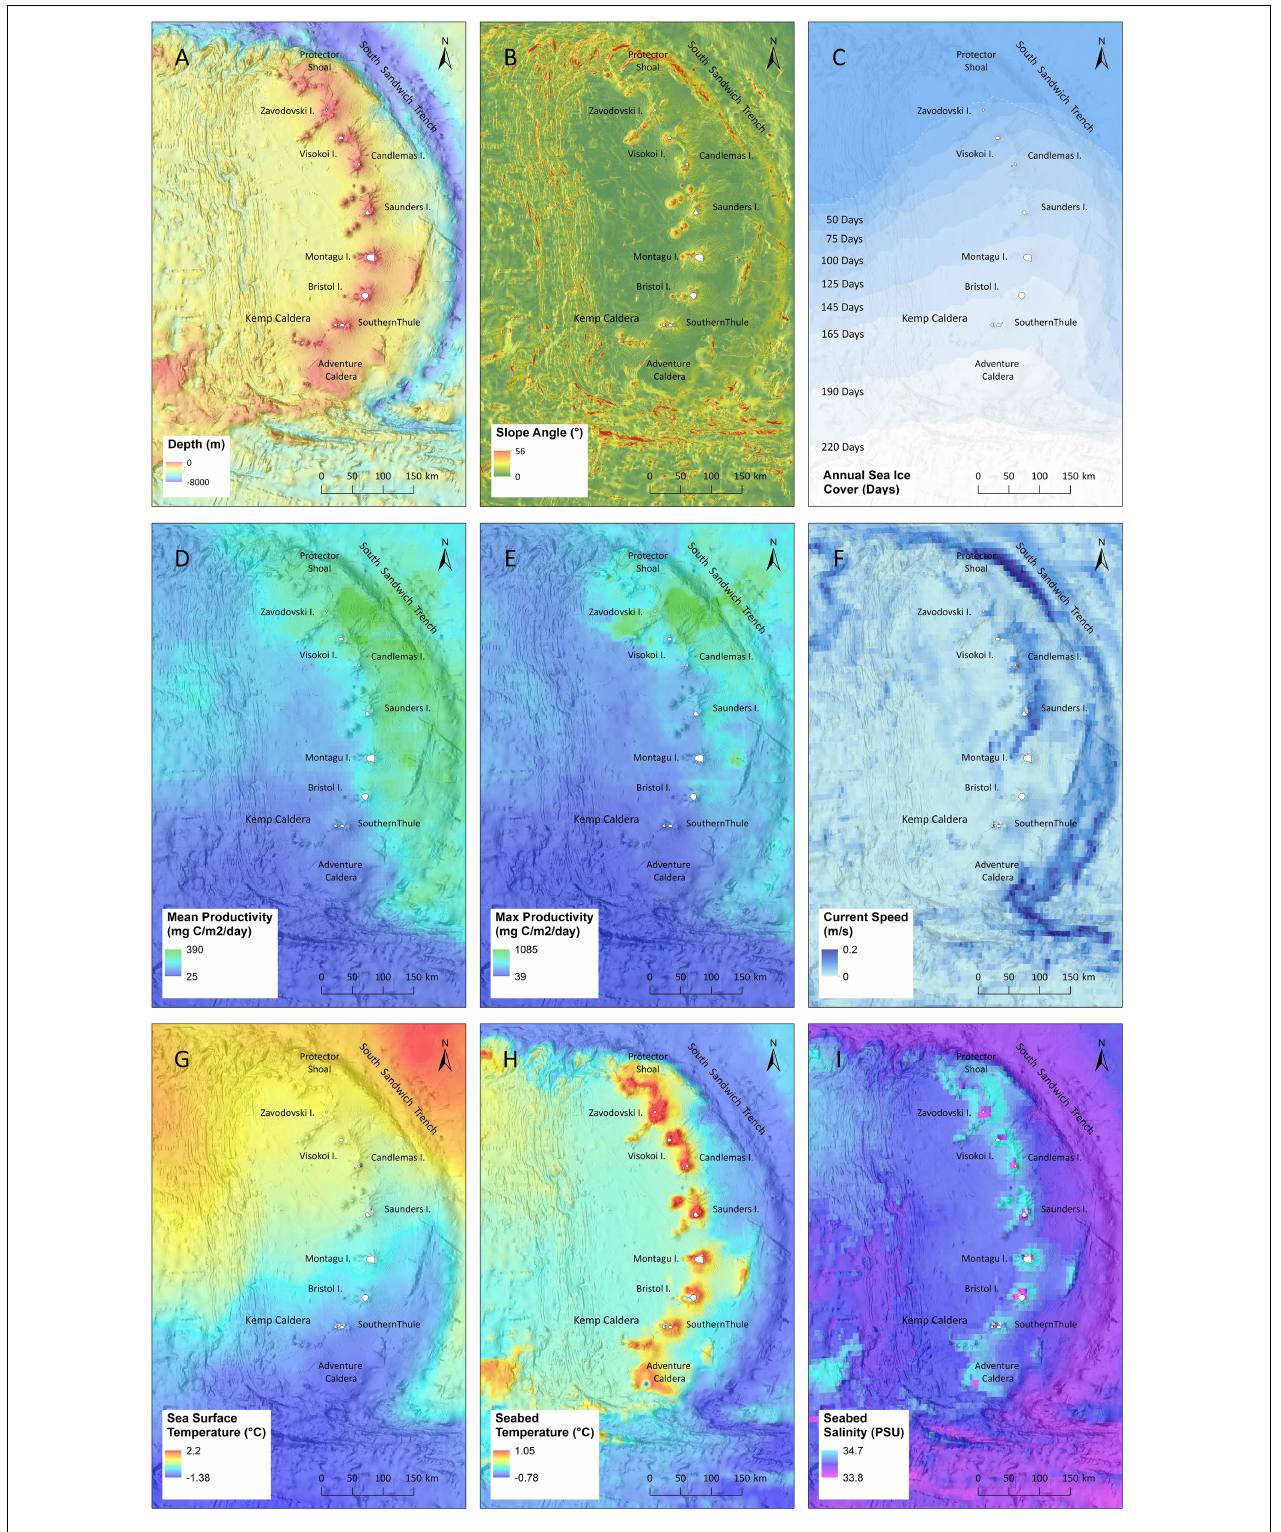
FIGURE 5 | Summary of regional environmental datasets: (A) depth, (B) slope, (C) sea ice, (D) mean primary productivity, (E) peak primary productivity, (F) current speed, (G) sea surface temperature, (H) seabed temperature, and (I) seabed salinity. Panels (D–I) show mean summer conditions. A full description of all the data including data sources are summarised in Supplementary Table 1